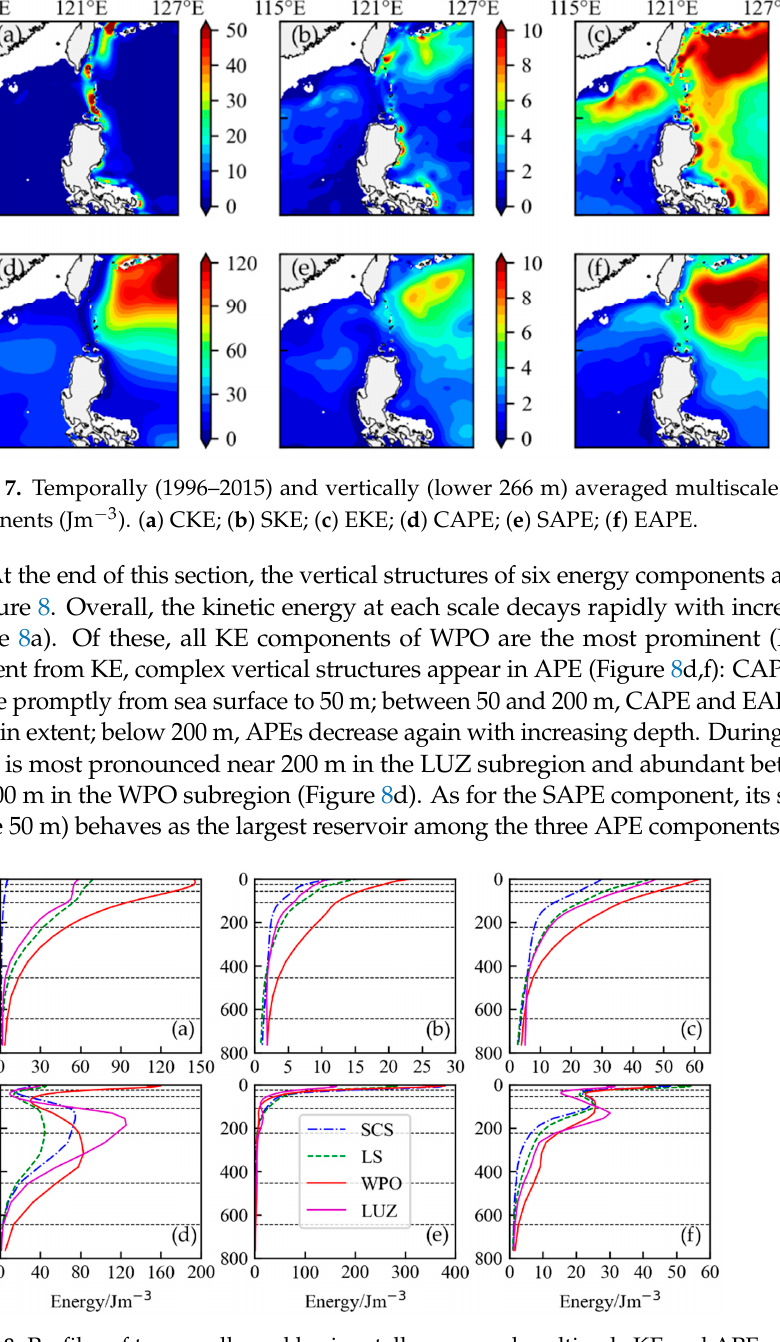
Figure 8. Profiles of temporally and horizontally averaged multiscale KE and APE components in four subregions (see Figure 1 for locations). The black dotted lines (from top to bottom) in each subgraph indicate depths of 25, 56, 110, 222, 454 and 644 m, respectively. ( a ) CKE; ( b ) SKE; ( c ) EKE; ( d ) CAPE; ( e ) SAPE; ( f ) EAPE.